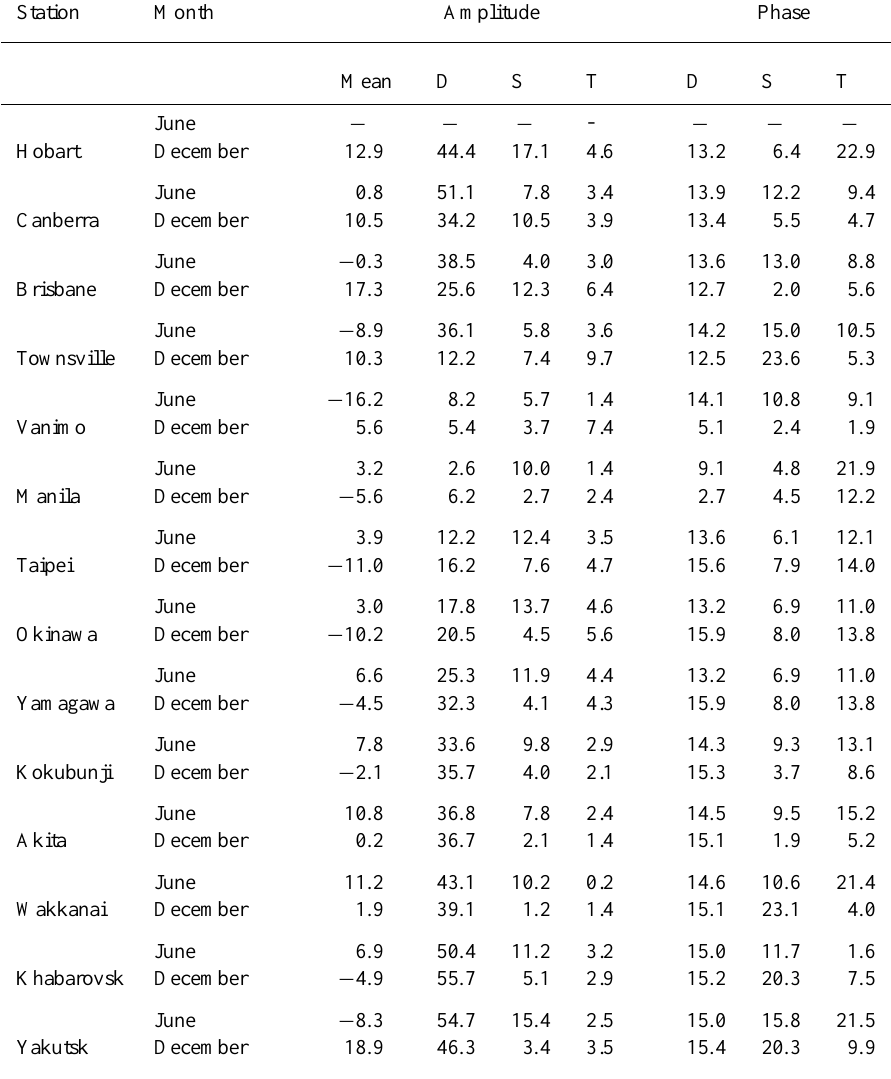
Table 3. Diurnal mean velocity (m/s) of equivalent winds, and their diurnal (D), semidiurnal (S), and terdiurnal (T) amplitude (m/s) and phase (UT, hour) for solstice periods of June and